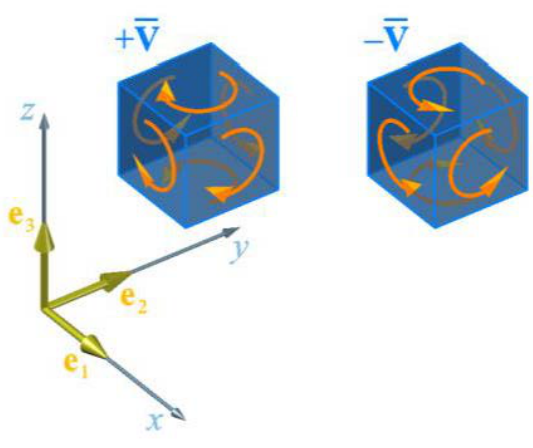
Figure 19: Positive and negative inner orientations of a